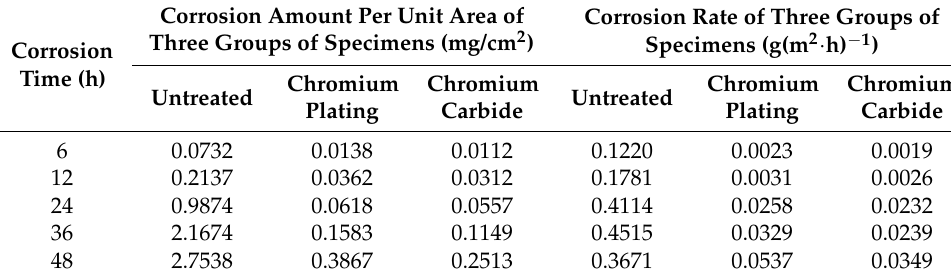
Table 6. The corrosion amount and corrosion rate of the three